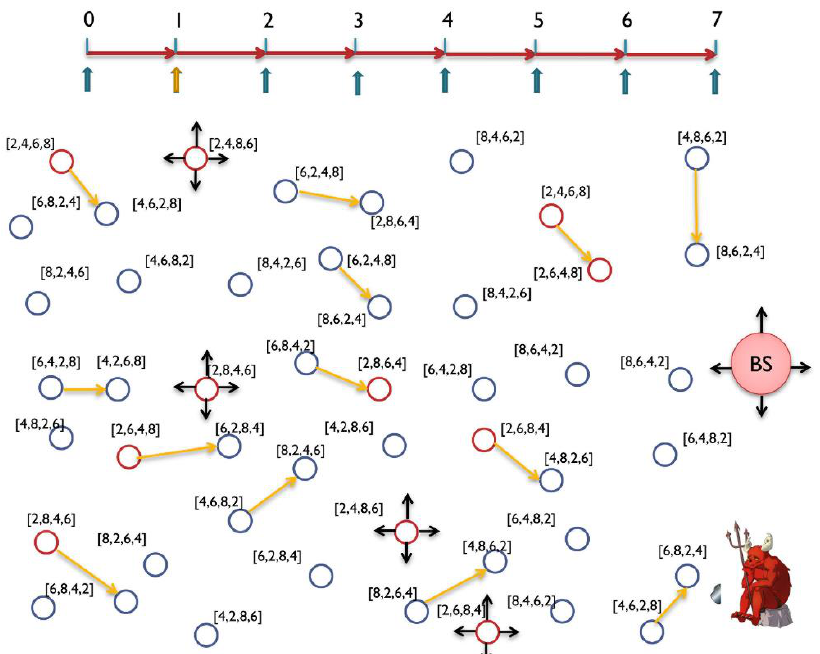
Figure 15. Any node assigned subinterval ω have a real message to report. All the nodes in the network can send real messages within any